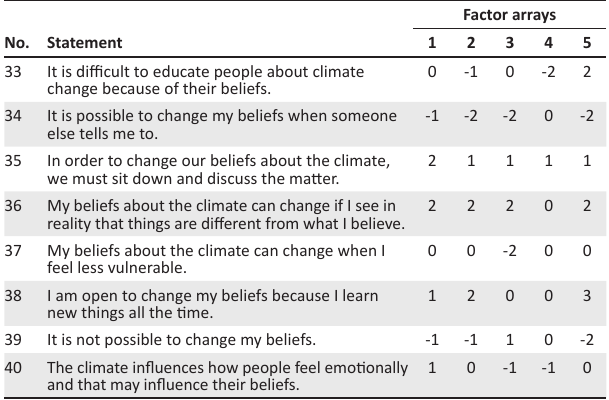
TABLE 5: Q-sorts related to